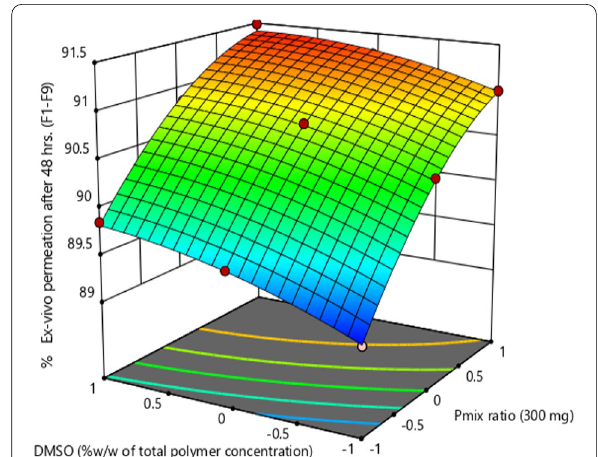
Fig. 8 Response surface plot of % ex vivo drug